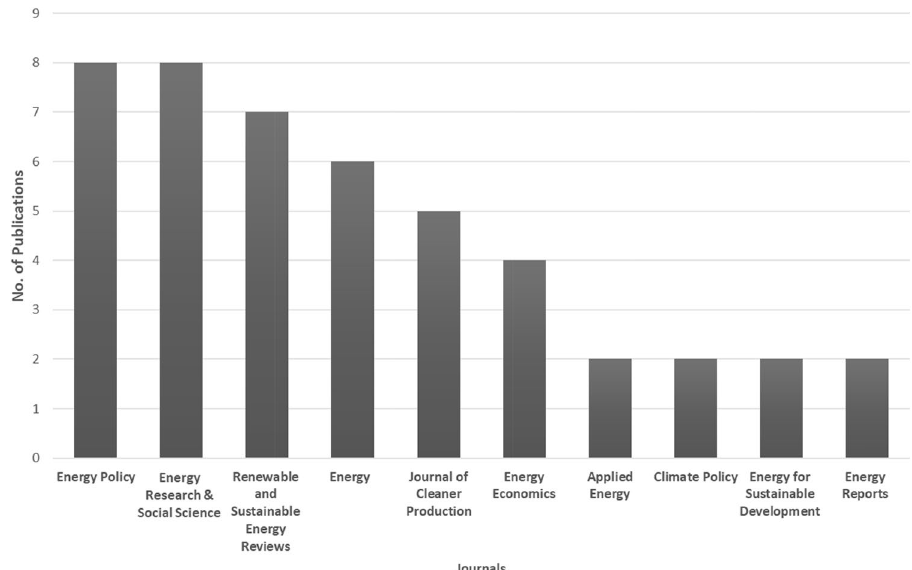
Fig. 2 Top ten journals based on the number of